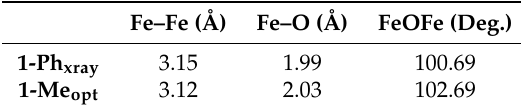
Table 2. X-ray and optimized structural